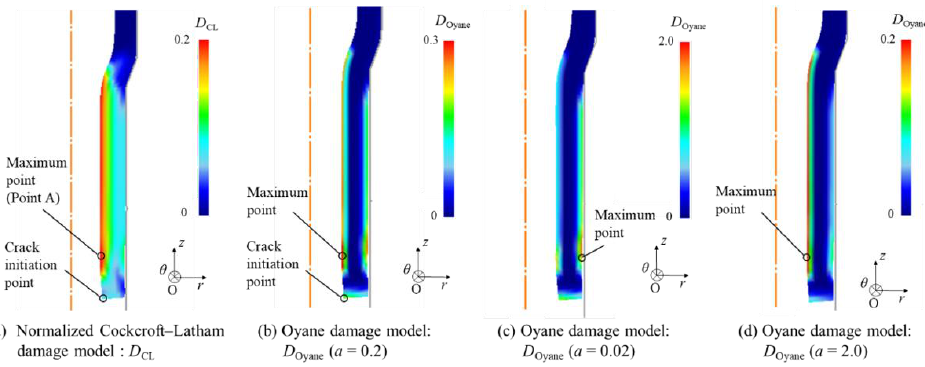
Figure 18. Comparison of the dimensions between the simulation results and the actual forged parts in the first forward extrusion process.